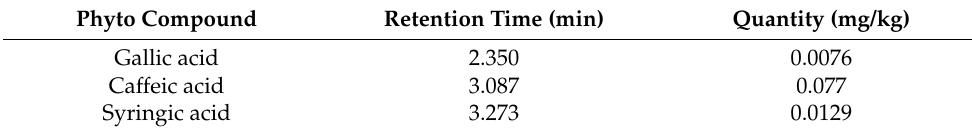
Table 2. Quantification of phytocompounds by HPLC analysis.